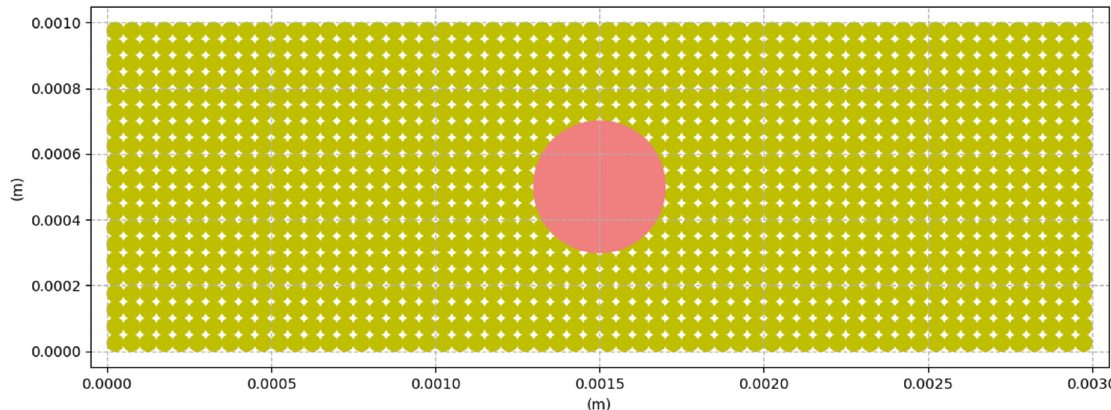
Figure 7. View of the heat input area in our simulation.